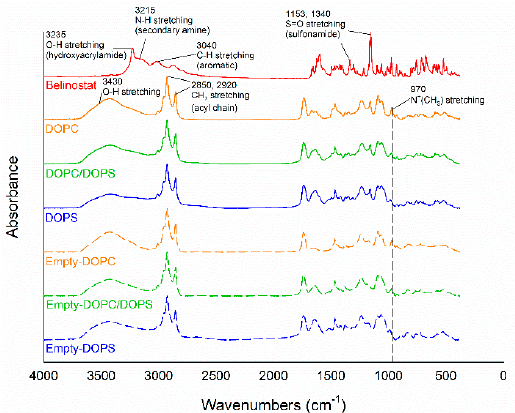
Figure 4. Fourier-transform infrared (FTIR) spectrum of belinostat free drug, empty liposomal formulations and belinostat-loaded liposomal formulations.